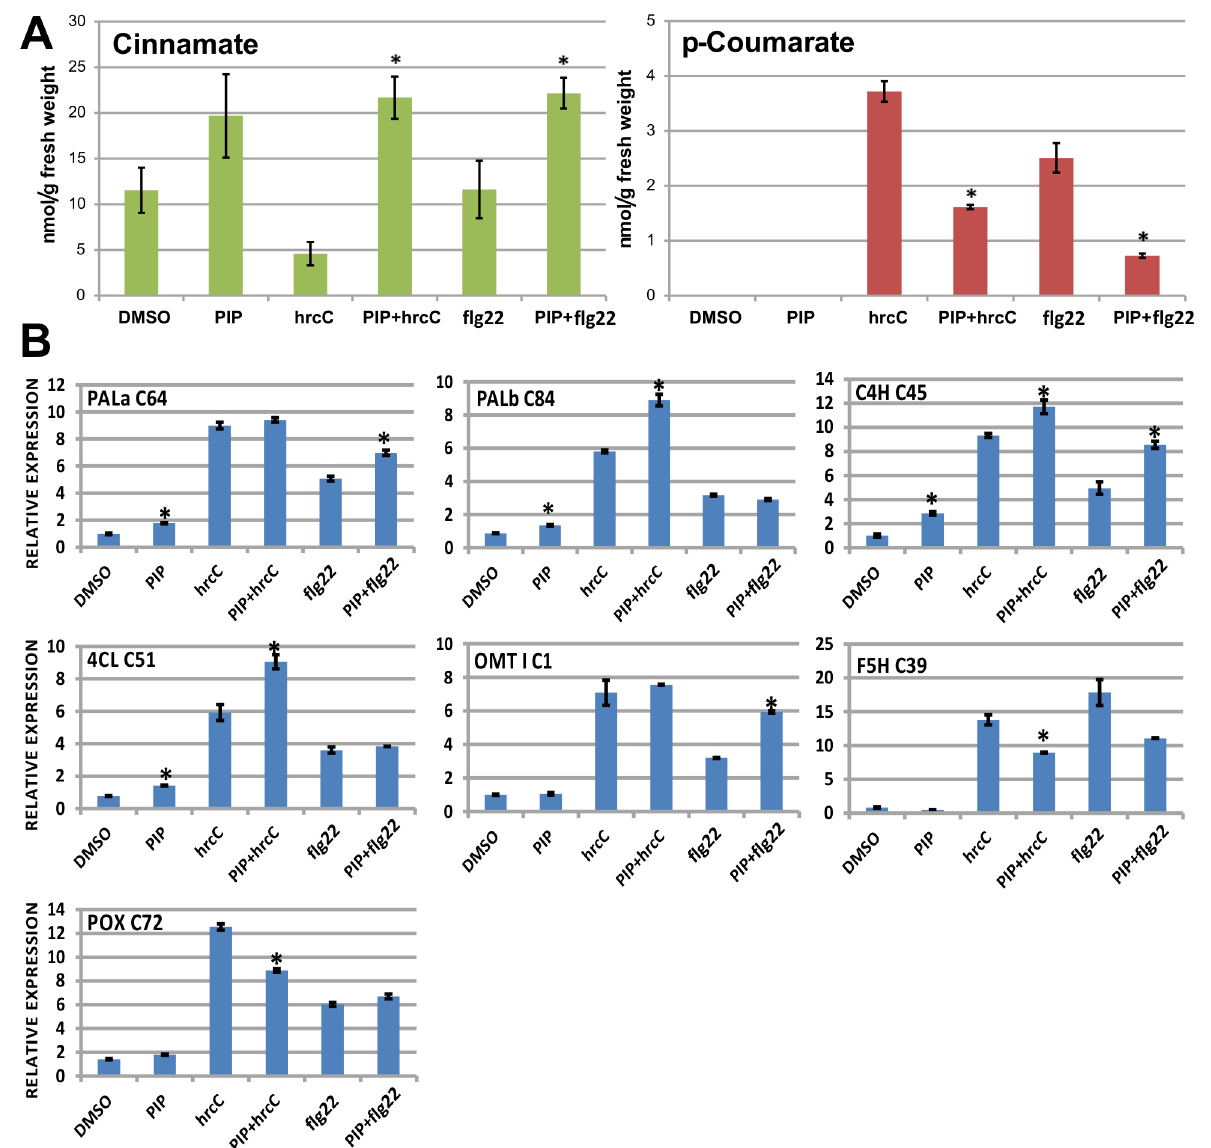
Figure 6. Changes in cinnamic acid and p-coumaric acid metabolite levels, and transcript levels of the related PPP enzymes in PTI- induced,PIPinhibitor-treated, andcontroltobaccoleaf tissue. A)Thin LayerChromatography (TLC) separation anddensitometricmeasurement of two phenolic compounds, cinnamic acid and p-coumaric acid in PTI-induced and control tobacco leaf tissue. Tobacco leaves were treated with dimethyl sulfoxide (DMSO), piperonylic acid (PIP), P. syringae hrcC - bacteria (hrcC), their combination (PIP + hrcC), flagellin 22 peptide (flg22) and combination of piperonylic acid and flagellin 22 peptide (PIP + flg22). Tissue samples (500 mg) were collected 6 hours after infiltration. Separation and detection of p-coumaric acid and cinnamic acid was carried out by thin layer chromatography (TLC) and UV densitometry. A standard line was created using commercially available p-coumaric acid and cinnamic acid to quantitate the two substances in the measured samples. Standard deviations are included in thediagram, andstars indicate significantdifference between PIP + PTIelicitors (PTI + hrcCor PTI + flg22) versus elicitor only treatments (hrcC or flg22 respectively) (p , 0.05). B) Measurement of gene-activation of phenylpropanoid pathway and lignification genes by real-time RT-PCR. Tobacco leaves were treated with dimethyl sulfoxide (DMSO), piperonylic acid (PIP), P. syringae hrcC - bacteria (hrcC), their combination (PIP + hrcC), flagellin 22 peptide (flg22) and combination of piperonylic acid and flagellin 22 peptide (PIP + flg22). Tissue samples (500 mg) were collected 3 hours after infiltration. Ratios of mRNA levels compared to water-treated controls are indicated. Values are averages of three replicates. Each replicate was normalized by corresponding actin levels. Stars indicate significant difference between DMSO control and PIP; furthermore between elicitor only treatments (hrcC or flg22) versus PIP + PTI elicitors (PTI + hrcC or PTI + flg22 respectively) (p , 0.05). PAL, Phenylalanine ammonia-lyase; C4H, cinnamate 4-hydroxylase; 4CL, 4-hydroxycinnamoyl-CoA ligase; OMT I, O-methyltransferase; POX, peroxidase; F5H, ferulate 5-hydroxylase.